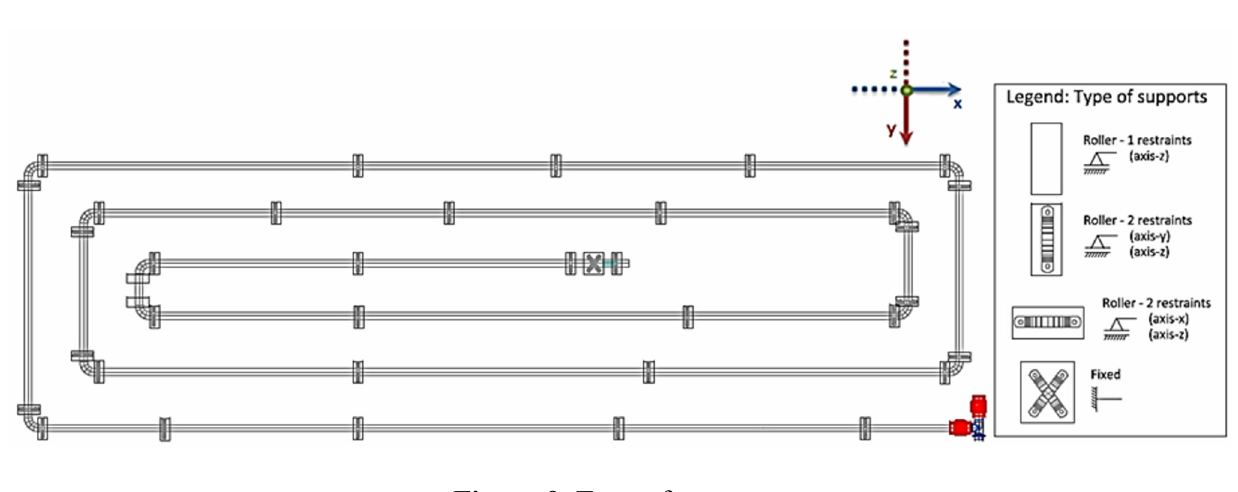
Figure 9. Type of